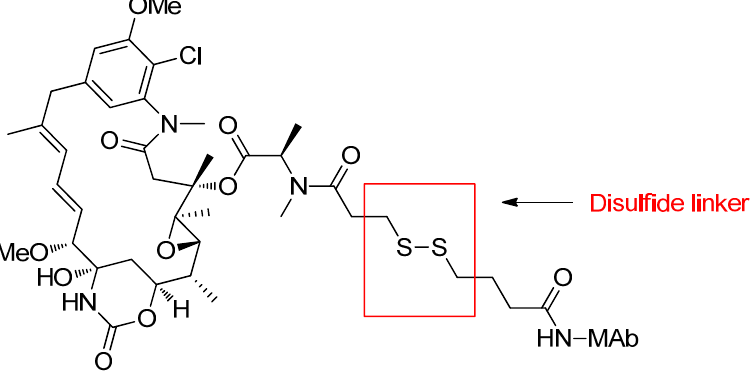
Figure 10. The structural formula ofIMGN901. Adapted from reference [72].